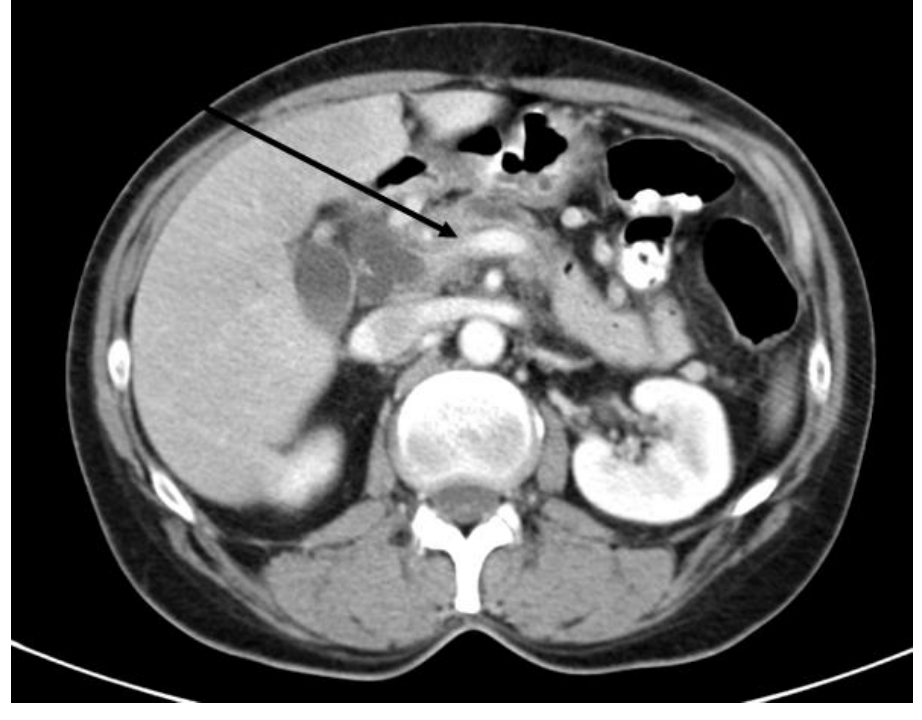
Figure 2. CT scan showing pancreatic head cancer with infiltration of the portal vein confluens (black arrow). Technically resectable finding (partial duodeno-pancreatectomy with segmental portal vein